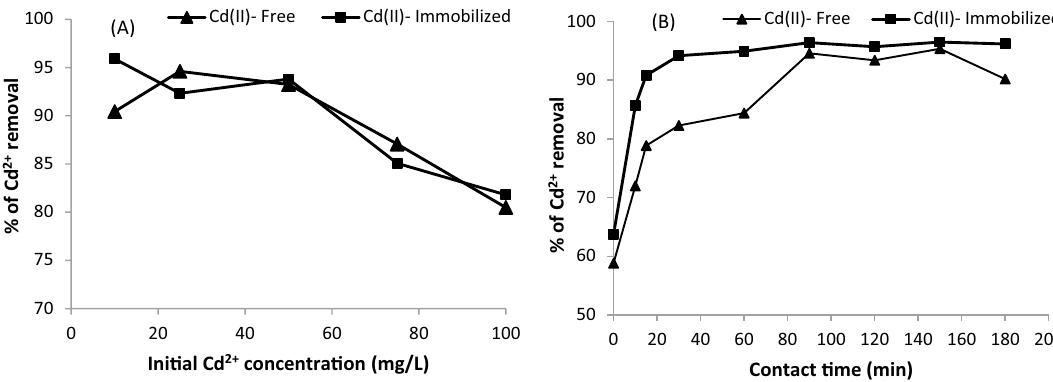
Figure 1. Impact of ( A ) the initial Cd 2+ concentration and ( B ) contact time on the removal percentage of Cd 2+ by the freely suspended and Ca-alginate-immobilized T. ornata cells (biosorbent dose = 4 g/L; pH = 5.0; contact time = 90 min; initial Cd 2+ concentration = 10 mg/L; temperature 25 °C; shaking at 170 rpm).